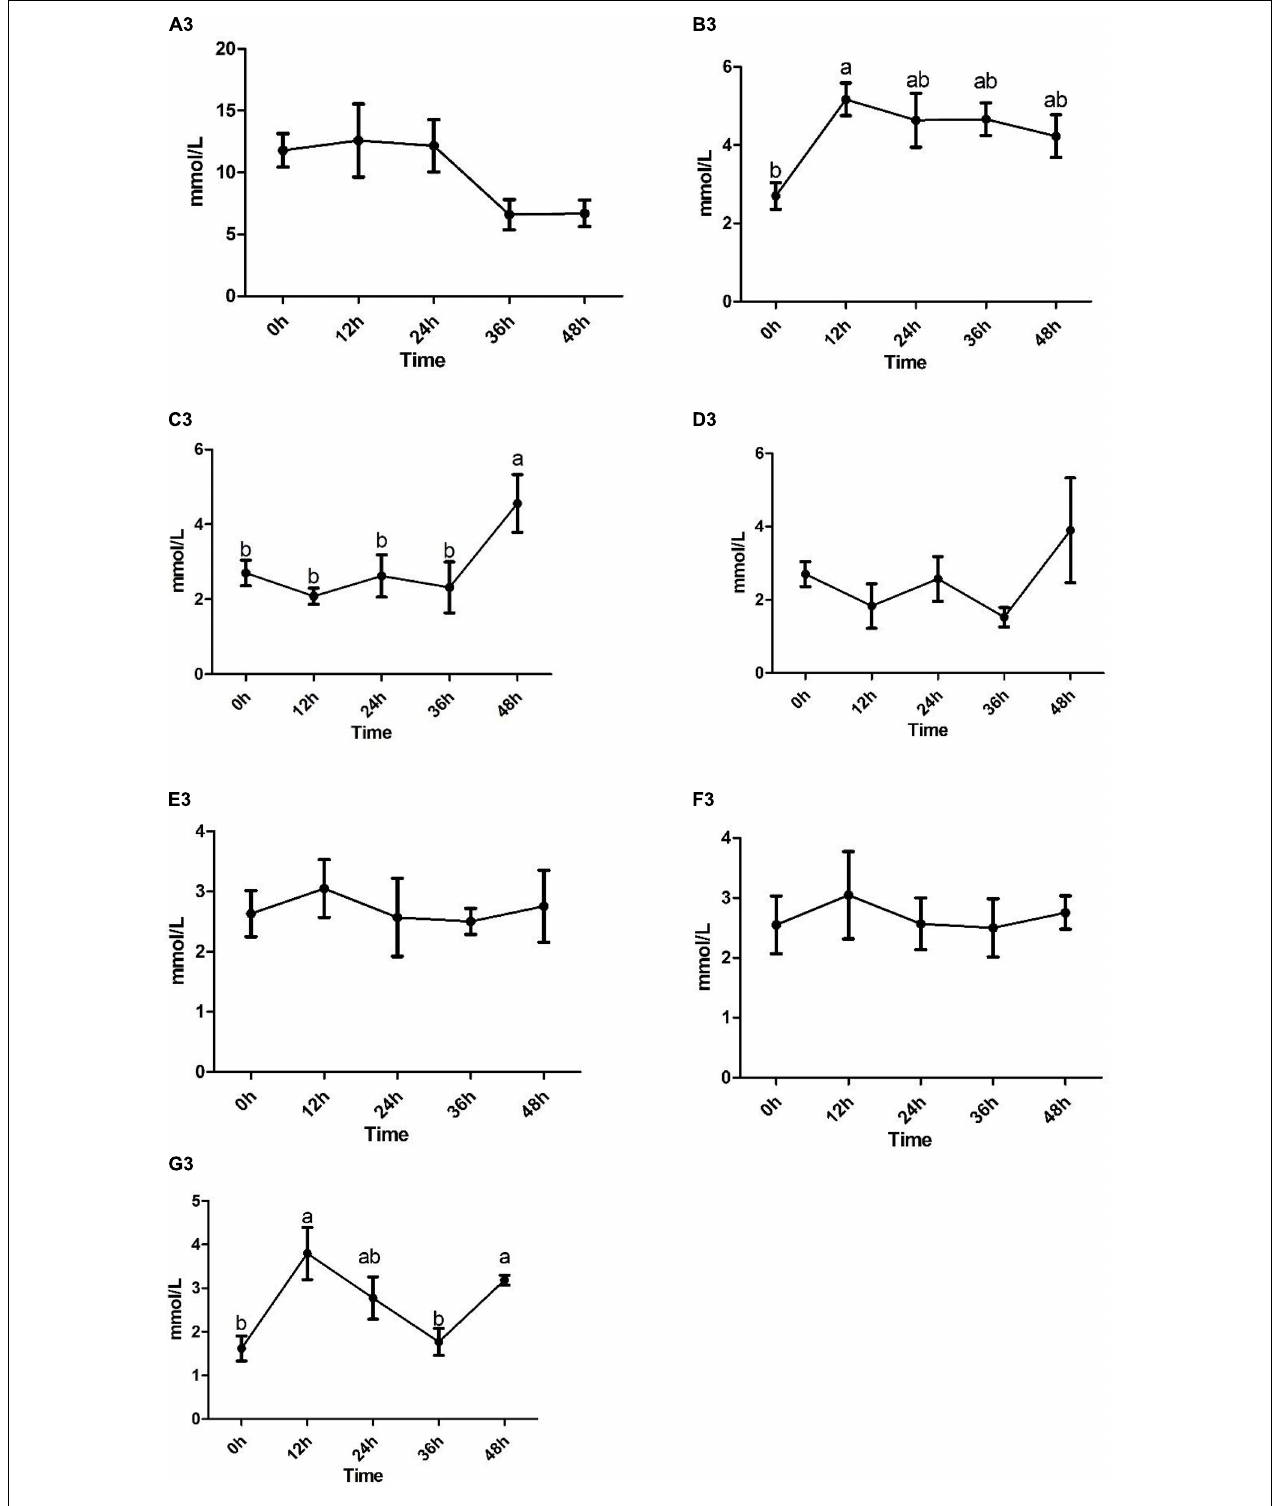
FIGURE 1 | The concentration of serum corticosterone (A1–G1) /cortisol (A2–G2) /glucose (A3–G3) and the dynamic changes of Channel Catfish before and after stress were observed under seven stresses: ammonia nitrogen, high temperature, acid, alkali, Aeromonas hydrophila, high salinity, and hypoxia. Values are represented as mean ± SE ( n = 10). Mean values with different letters (a–c) were significantly different ( P < 0.05).